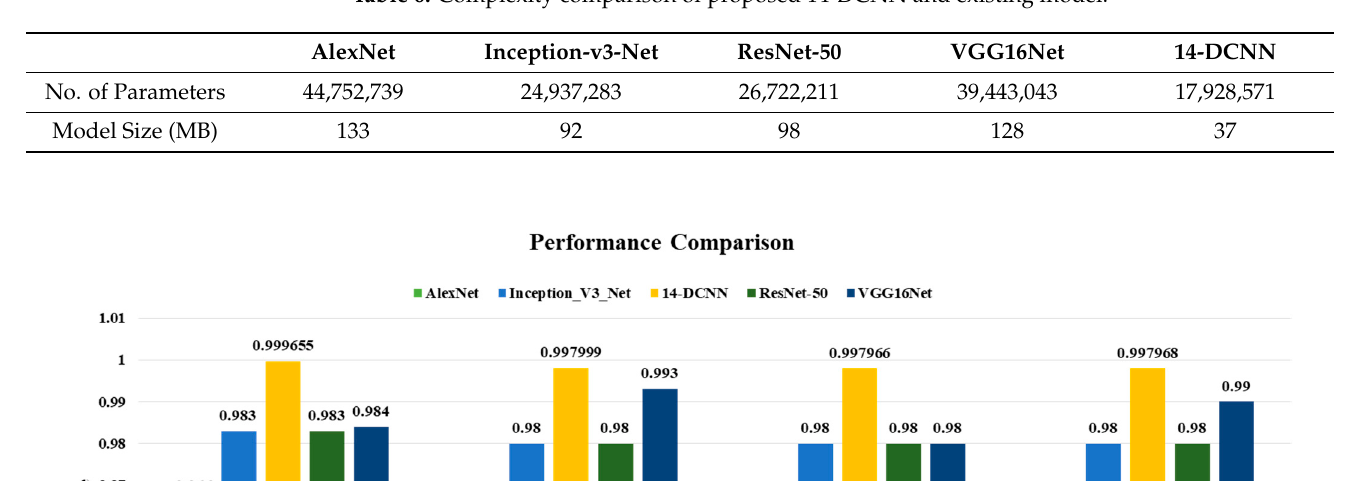
Table 6. Complexity comparison of proposed 14-DCNN and existing model.